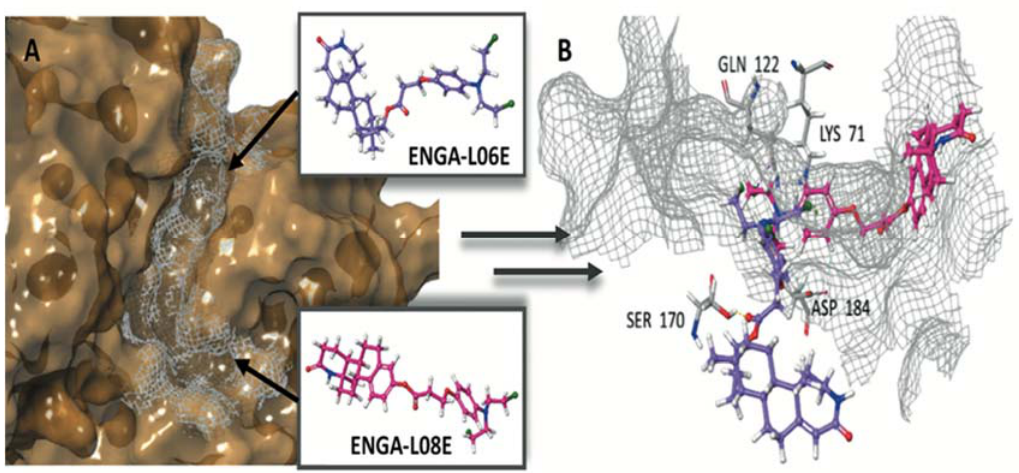
Figure 7. ( A ) The active site cavity of ERK and ( B ) Superimposition of calculated molecules ENGA-L06E and ENGA-L08E given in purple and pink colored carbons, respectively, with labeling of the critical bonding residues.